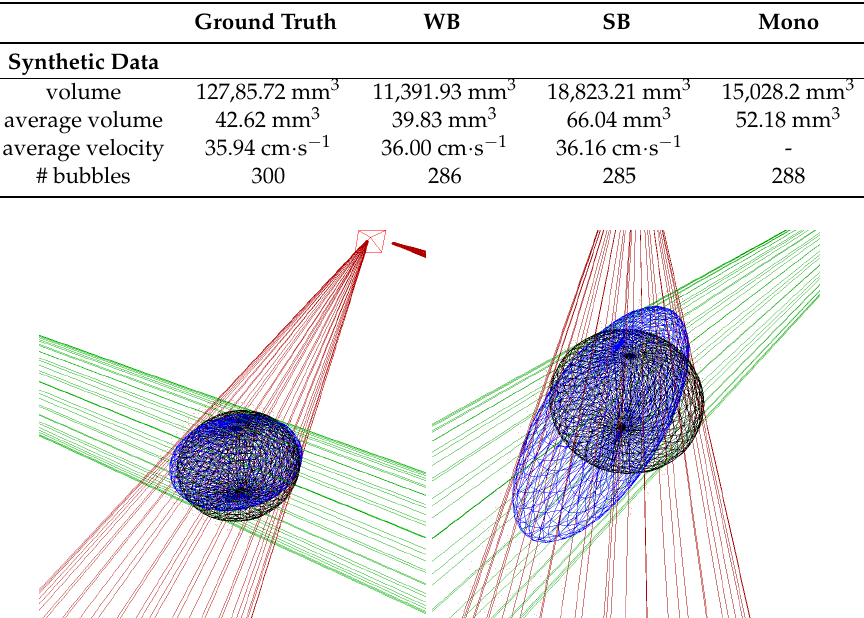
Figure 15. Ellipsoid triangulation from wide and small baseline. Left : wide baseline scenario, where blue shows the computed ellipsoid and black the ground truth ellipsoid. The green and red lines show the 3D cone limiting the ellipsoid. Right : small baseline scenario. Note how the blue ellipsoid cannot be determined uniquely due to the elongated intersection of the red and green viewing cone.